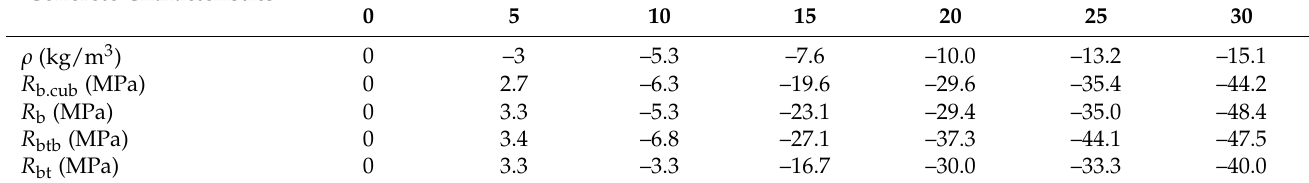
Table 4. Change in the characteristics of concrete ( ∆ ) in % depending on the amount of mineral coarse aggregate replaced by walnut